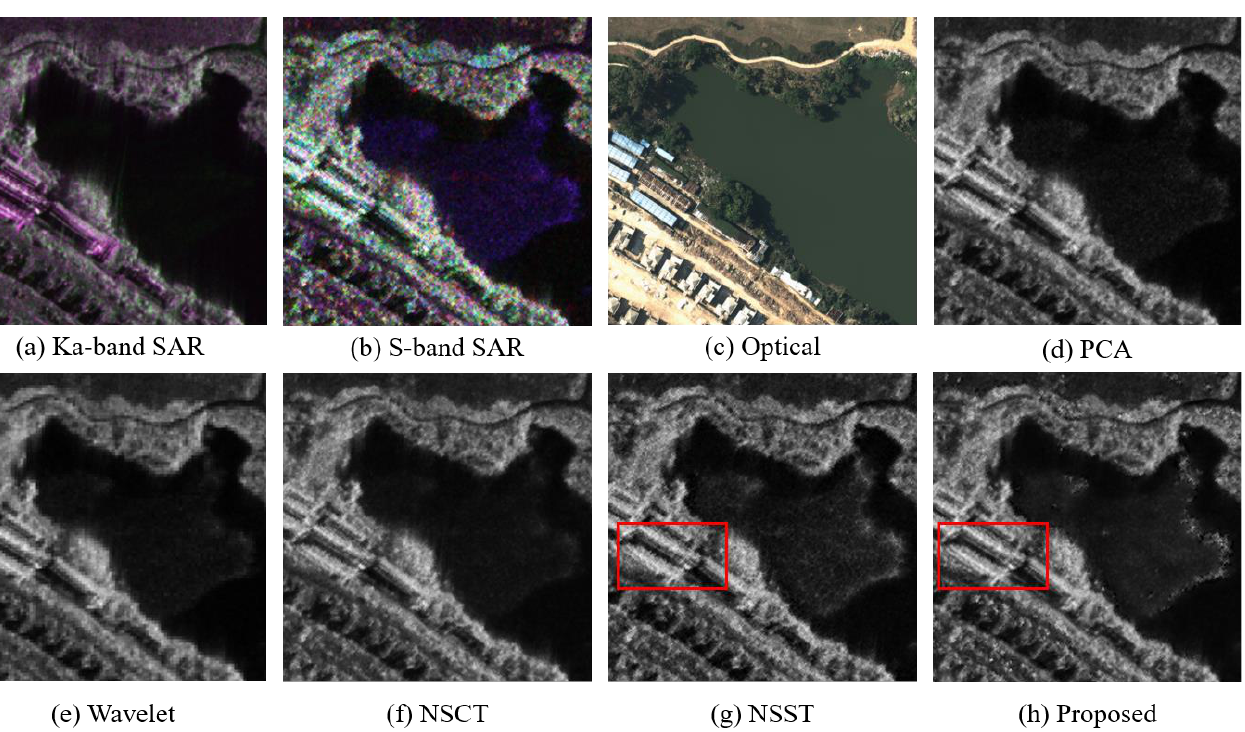
Figure 6. Enlarged marked region in scene 1: ( a ) Enlarged marked region in the NSST fusion; and ( b ) enlarged marked region in the proposed method fusion.